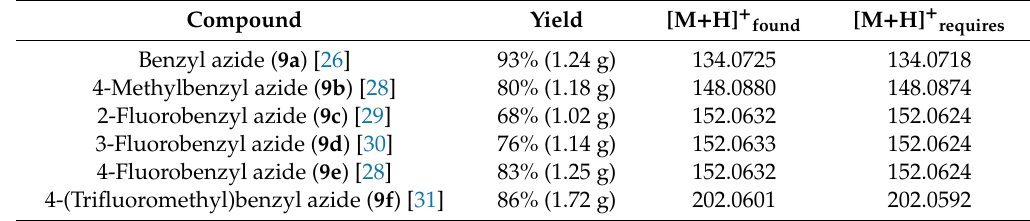
Table 3. MS Data for benzyl azides ( 9a–f